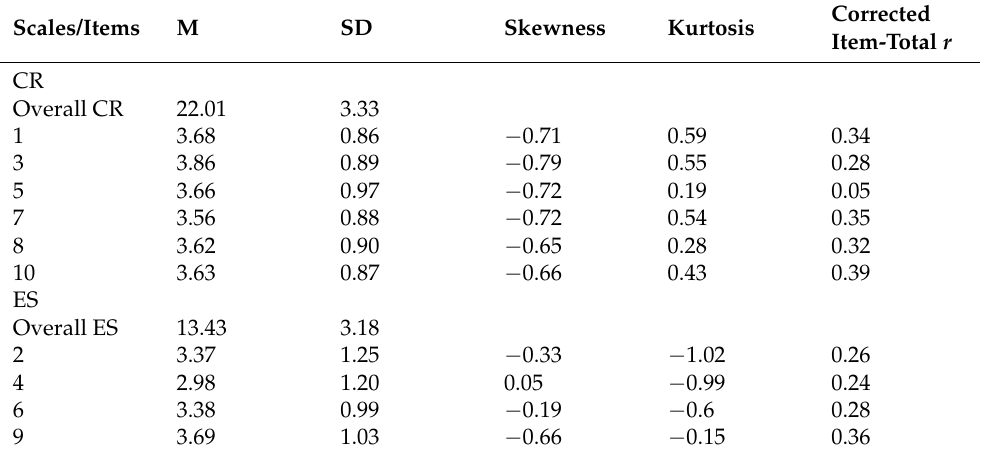
Table 2. Mean (M), standard deviation (SD), skewness, kurtosis, and corrected item-total r for all items of the Malay version of the ERQ-CA in Study